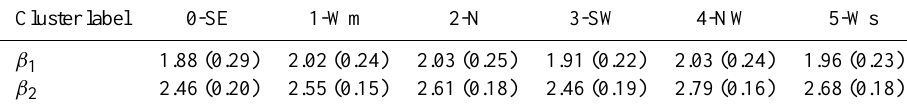
Table 3. Average spatial spectral exponents stratified by flow regime. The standard deviation over space is given in brackets. Cluster label